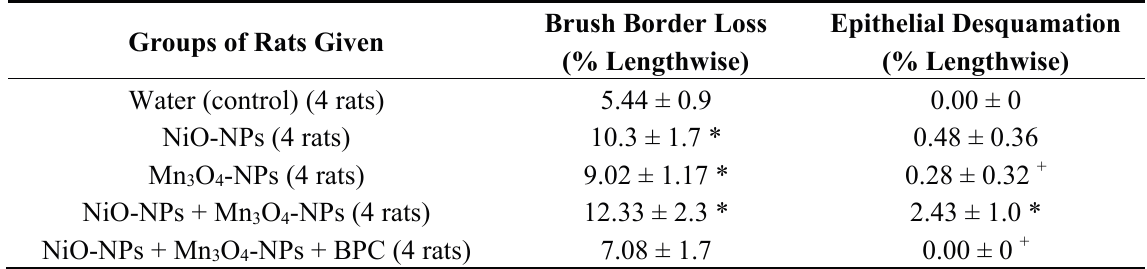
Figure 4. Kidney of a rat exposed to nanoparticles of NiO and Mn 3 O 4 together against the background BPC administration. Marked alleviation of tubular damage (compare with Figures 2 and 3). PAS stain, magnification ×400. Table 4. Morphometric indices for tubular epithelium damage in the kidneys of rats after repeated intraperitoneal injections of NiO or Mn 3 O 4 nanoparticles, together or separately, and of their combination with background oral administration of the BPC (X ±